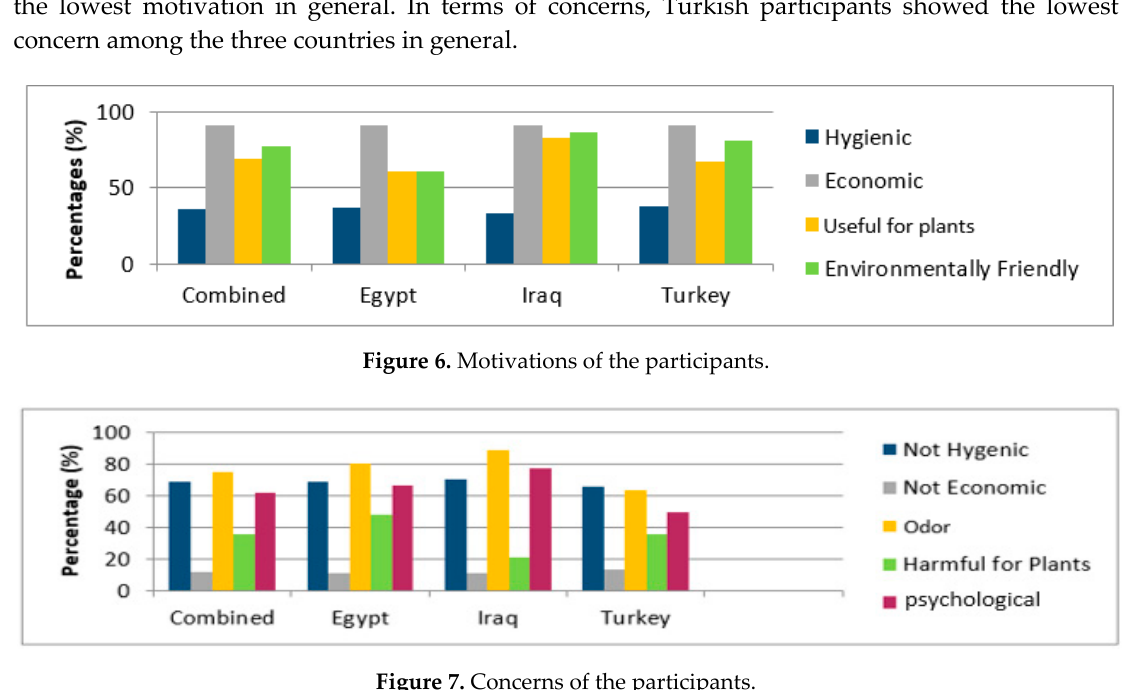
Figure 7. Concerns of the